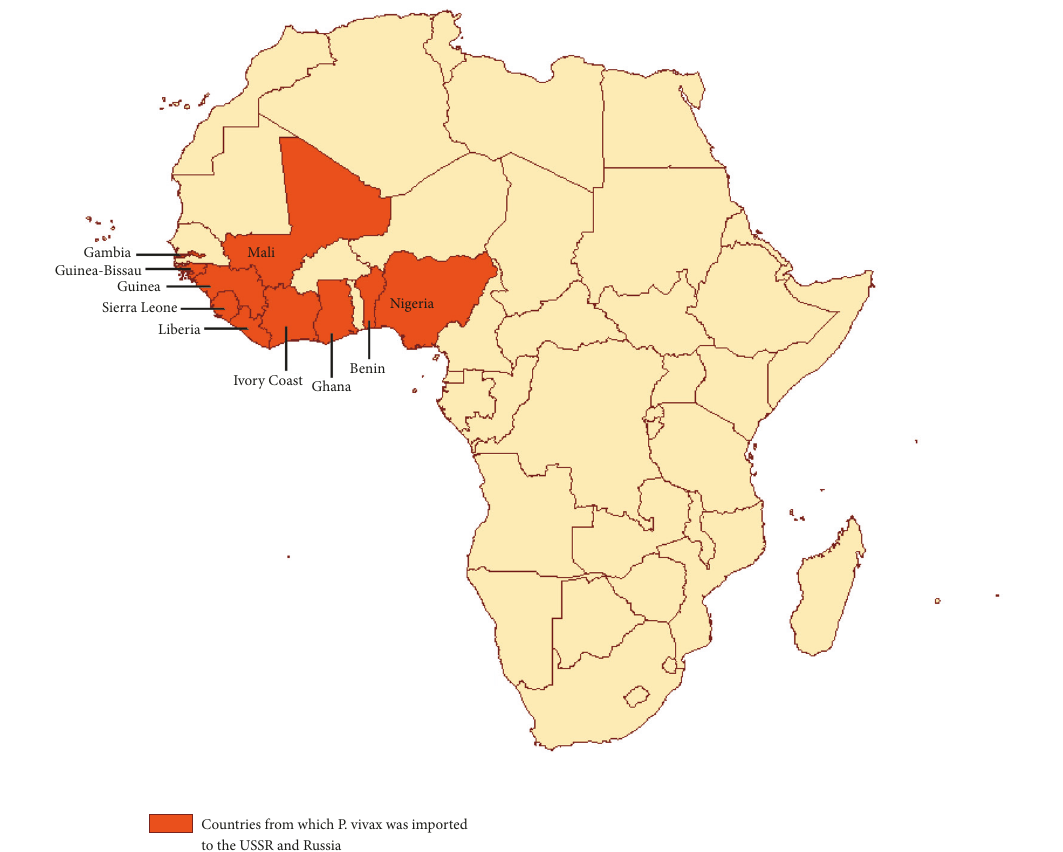
Figure 1: Countries of western Africa served as a source of imported P. vivax malaria to the USSR and Russia.